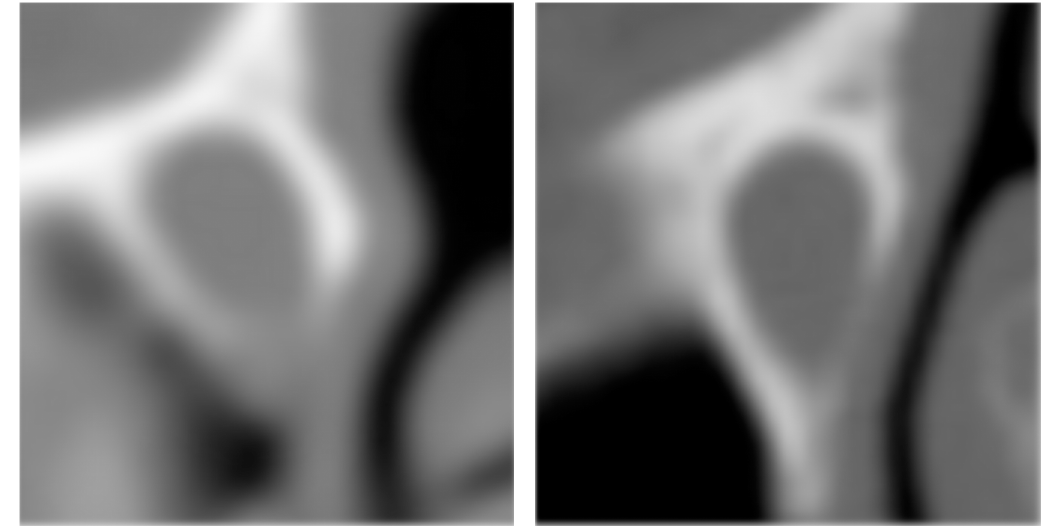
Fig 6. Wall thickness inhomogeneity in the nasolacrimal